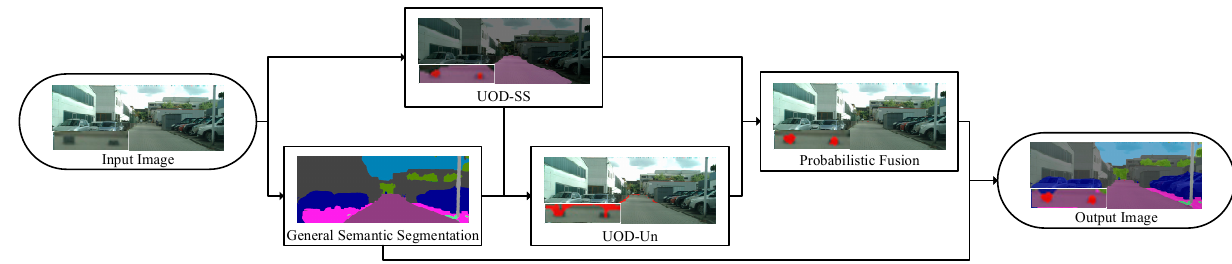
Figure 1. Flowchart of the method.